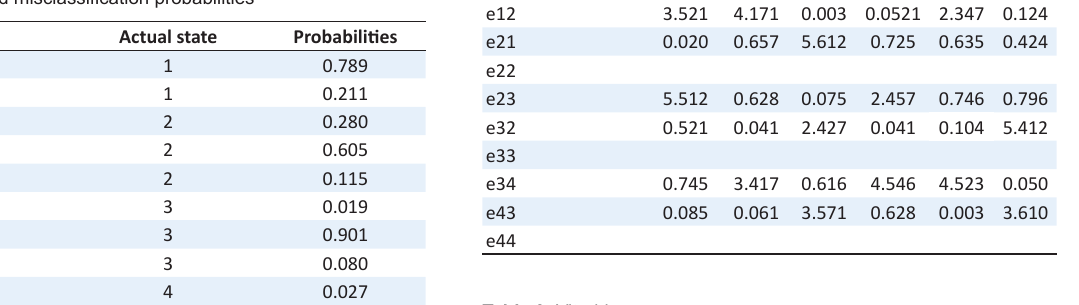
Table 9. Viterbi